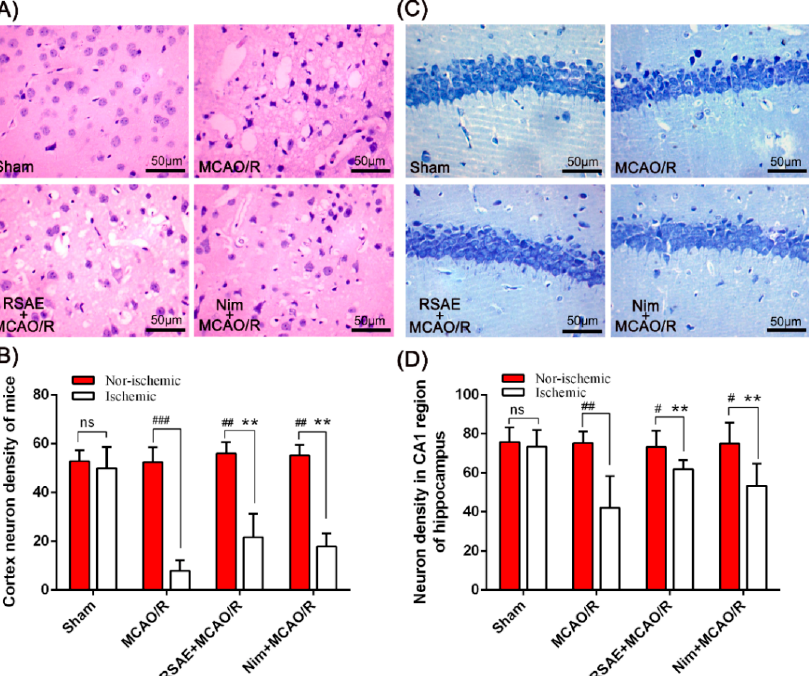
Figure 6. Representative images of H&E and Nissl staining performed on sections from ischemic brain at 24 h after ischemia/reperfusion in mice. ( A ) Representative H&E staining in the cortex at 24 h after ischemia/reperfusion. ( B ) The ischemic and nonischemic cortex neuron density of mice after focal cerebral ischemia. ( C ) Representative Nissl staining in the cortex at 24 h after ischemia/reperfusion. ( D ) The neuron density in the CA1 region of the hippocampus of mice after focal cerebral ischemia. Mean values ± standard error of the mean (n = 10); * p < 0.05, ** p < 0.01 versus MCAO/R group; # p < 0.05, ## p < 0.01, #### p < 0.0001 versus sham-operated group; ns means not significant. Scale bar, 50 μ m.